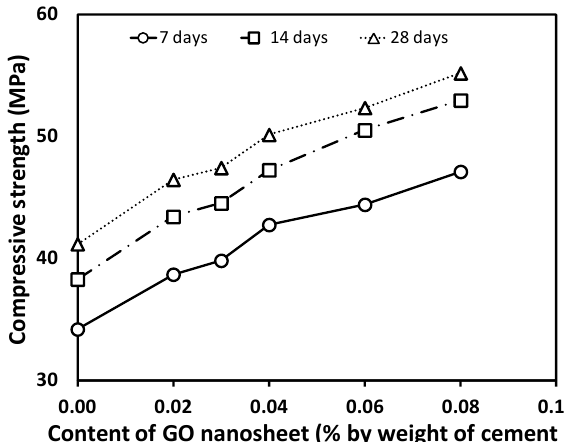
Figure 4. Compressive strength of concrete with varying graphene oxide (GO) content.